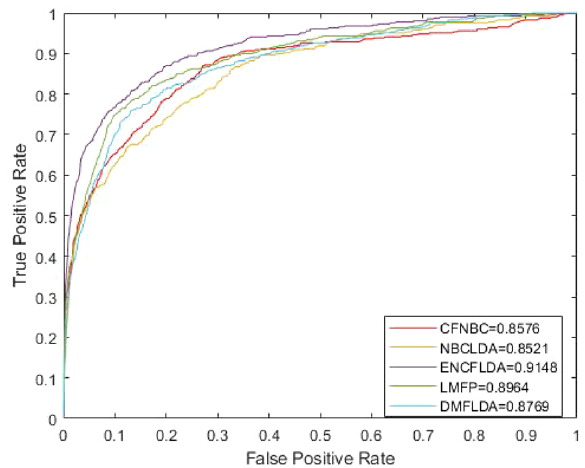
Figure 1. ROC comparison between ENCFLDA and other advanced models based on the same data